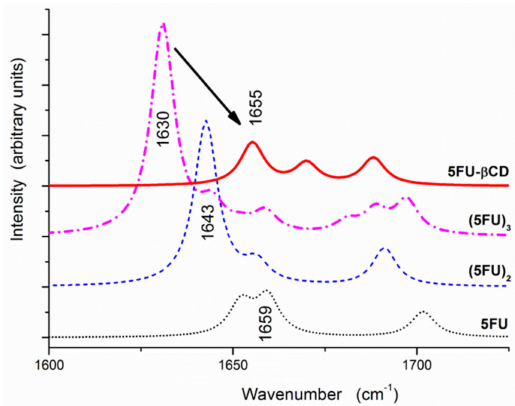
Figure 4. Fragments of theoretical IR spectra containing C = O and C = C stretching vibrations, calculated for the 5-FU monomer, dimer and trimer, as well as the 5-FU / β -CD complex. The calculated harmonic wavenumbers were scaled by a factor of 0.968